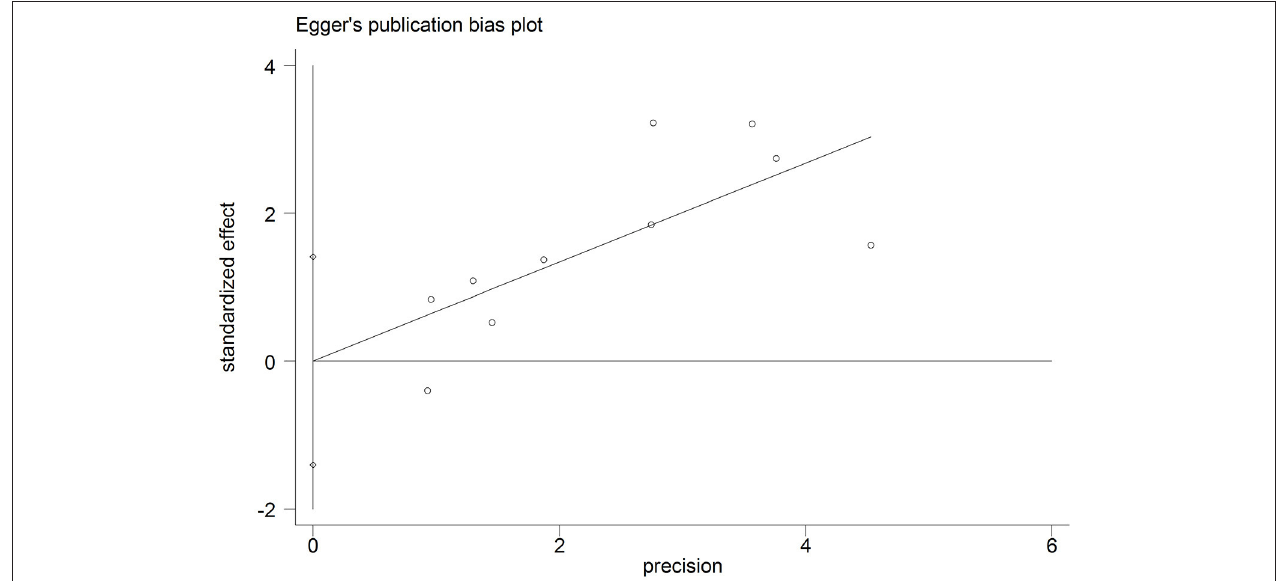
FIGURE 6 | Funnel plot analysis of potential publication bias in OS group (Eegg’s test): OS group.